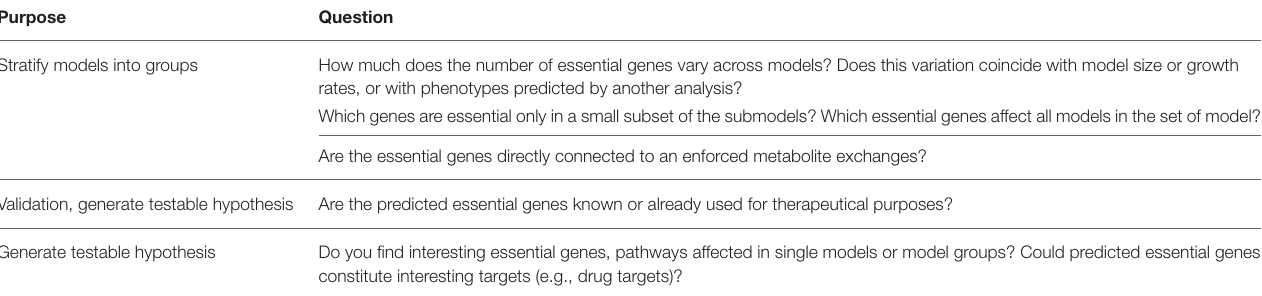
TABLE 4 | Questions to guide the analysis of predicted sets of essential